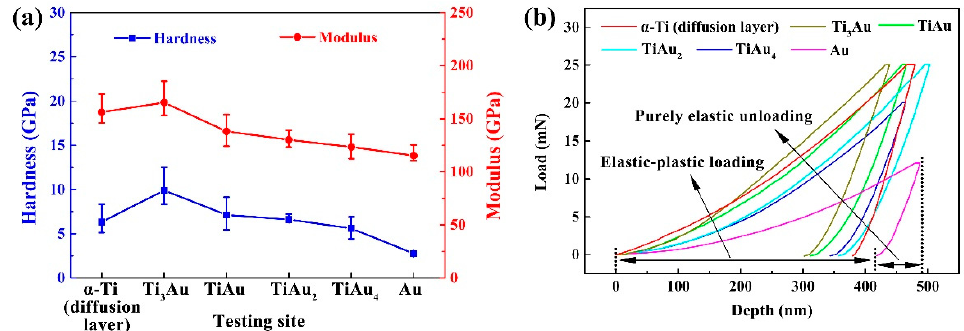
Figure 11. ( a ) Hardness and elastic modulus distribution across the joint interface; ( b ) typical load versus depth curves.